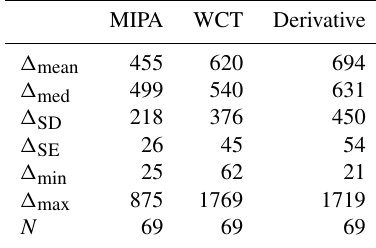
Table 2. Statistical analysis of the absolute differences with re- spect to the reference of the ABLH retrieved by applying MIPA, WCT and derivative approaches on Potenza 72h high-resolution time series of the total attenuated backscatter at 1064nm. The mean ( (cid:49) mean ), the median ( (cid:49) mean ), the standard deviation ( (cid:49) SD ), the standard error ( (cid:49) SE ), the minimum and the maximum of the absolute differences are given in meters. N is the number of points on which the statistics are made. The reference is assumed to be the ABLH calculated from the co-located atmospheric temperature and pressure profiles provided by ECMWF forecasts.